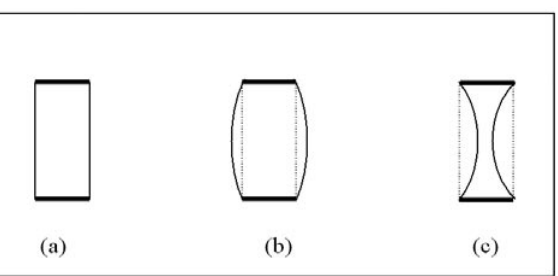
Figure 3 . Profile of the Adspec. (a) Plano (b) Convex and (c) Concave. (Reproduced with permission from S Afr Optom 2005 64 )